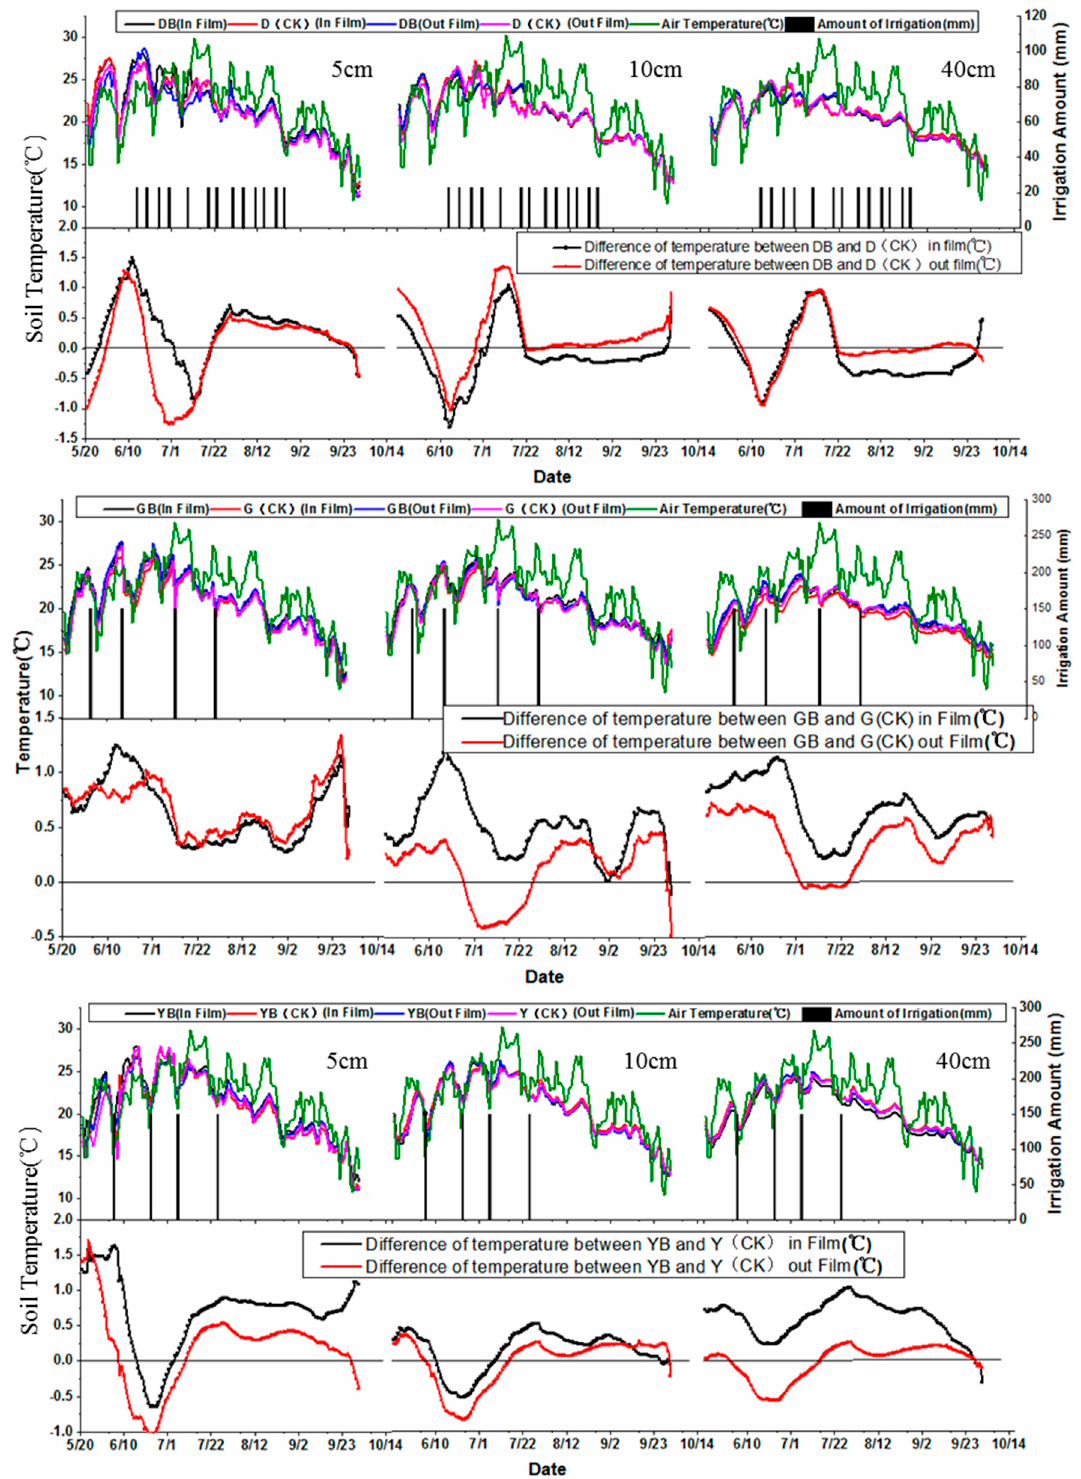
Figure 7. Seasonal dynamic changes of soil temperature in 2017. Note: 5 cm, 10 cm and 40 cm represent the soil depth of 5 cm, 10 cm and 40 cm.